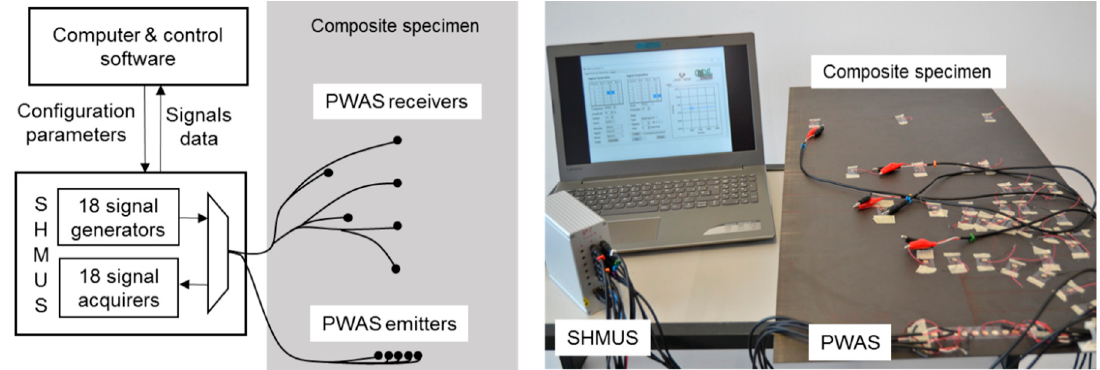
Figure 1. Schematic and photograph of the setup of the UGWT.